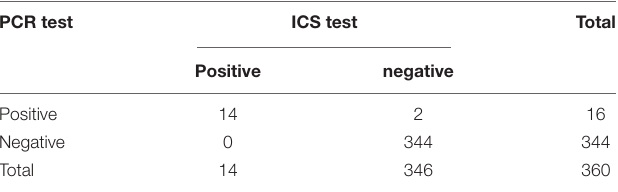
TABLE 3 | Canine adenovirus detection results via ICS and PCR for clinical samples from China.